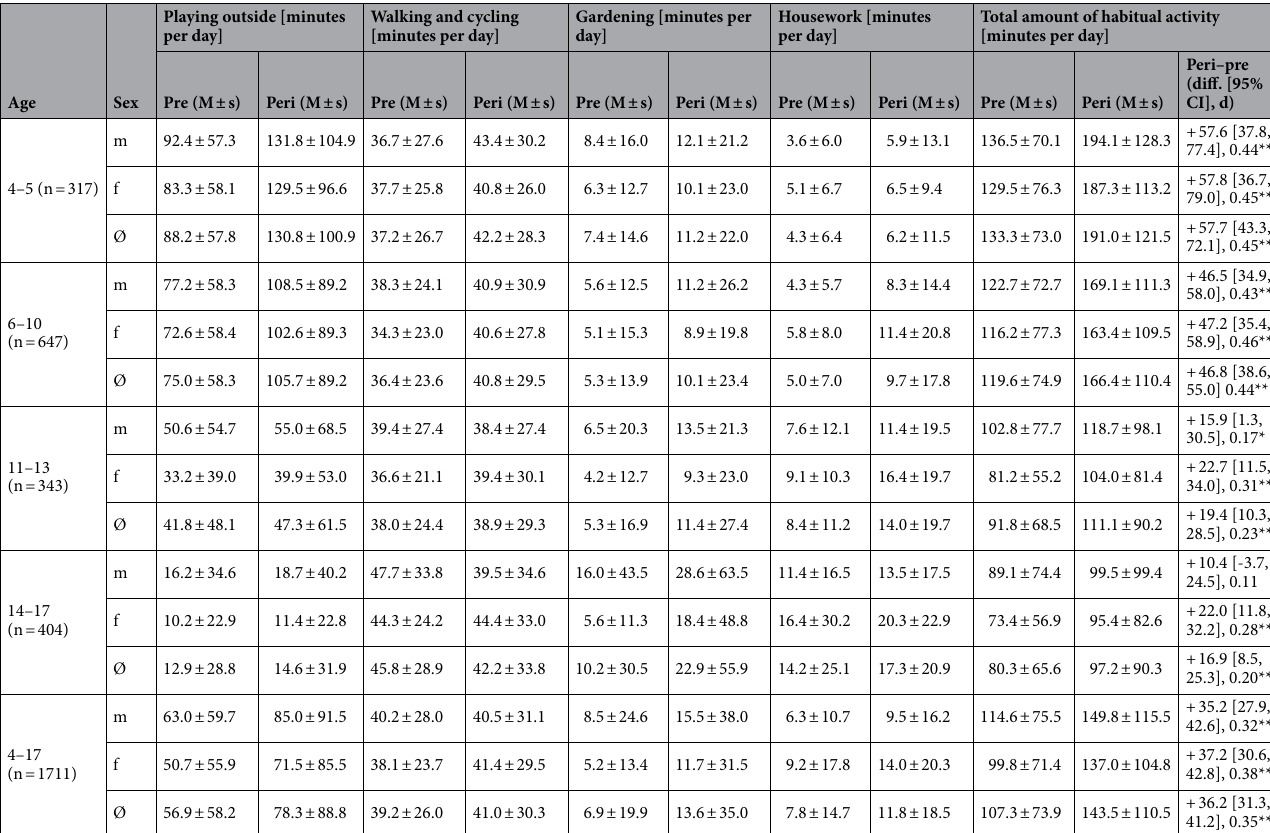
Table 3. Habitual physical activity before and during the COVID-19 lockdown in Germany (MoMo Study). m male, f female, Ø mean of males and females, M mean, s standard deviation, 95% CI 95% confidence intervals, d effect size Cohen’s d. * / **Significant difference (* p < .05; ** p <